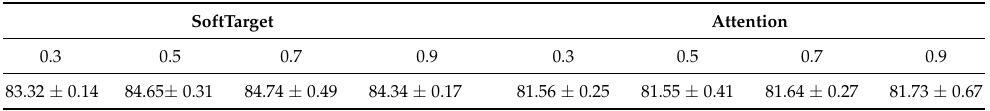
Table 6. Results of applying knowledge distillation from a ResNet34 to a ResNet18 architecture for 4 different β interpolation values. Mean and standard deviation of accuracy over 3 rounds are reported. The darker the shade of red, the further the accuracy is from the